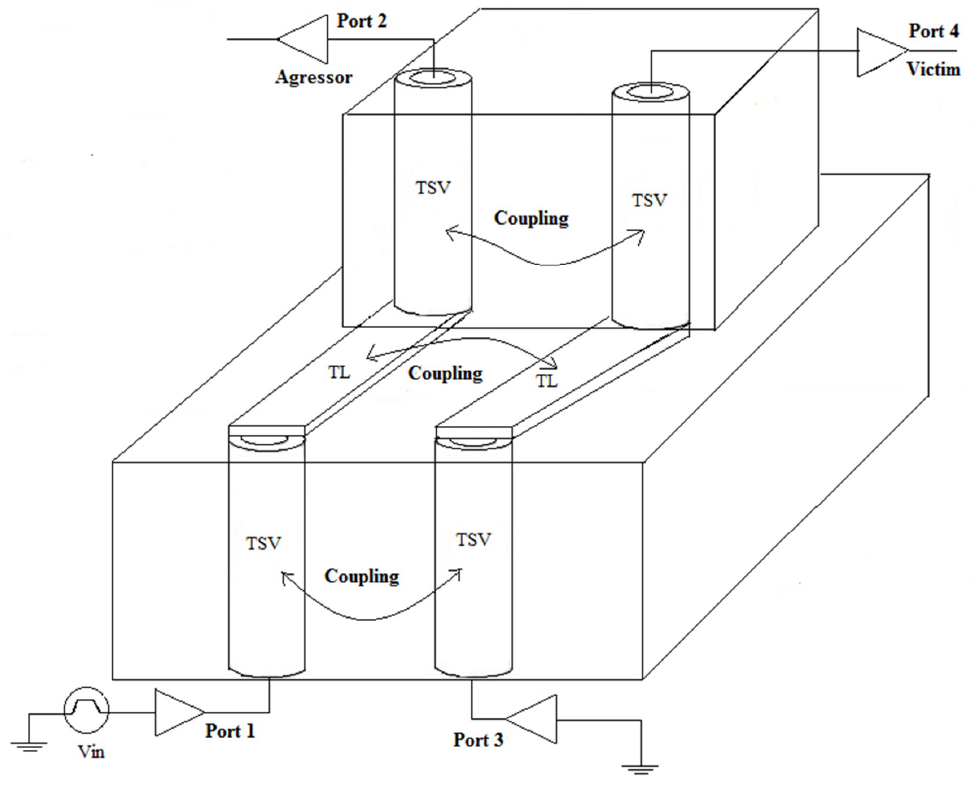
Figure 4. The conceptual view of a TSV noise coupling structure with interconnect lines and I / O drivers.